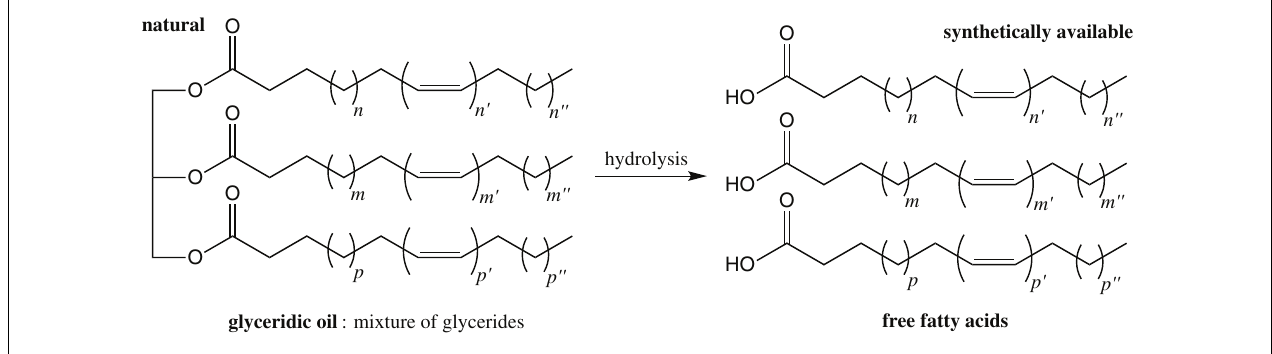
FIGURE 8 | Syntheses of free fatty acids that are derived from natural glyceridic oils.